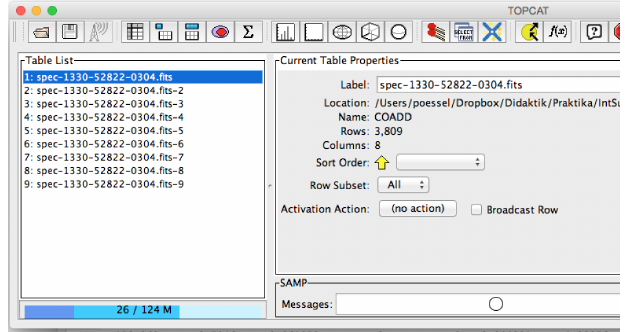
Fig. 76.— TOPCAT main window with SDSS DR8 spectrum